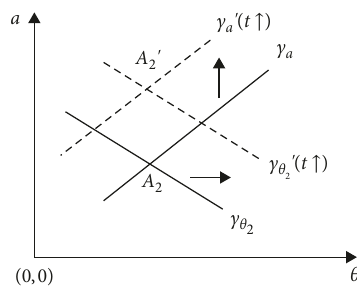
Figure 2: The impact of increasing the pollutant discharge rate t to levy probability θ 2 and pollution control probability α